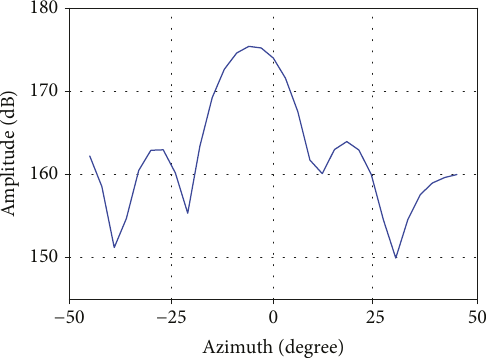
Figure 7: Target spatial spectrum.